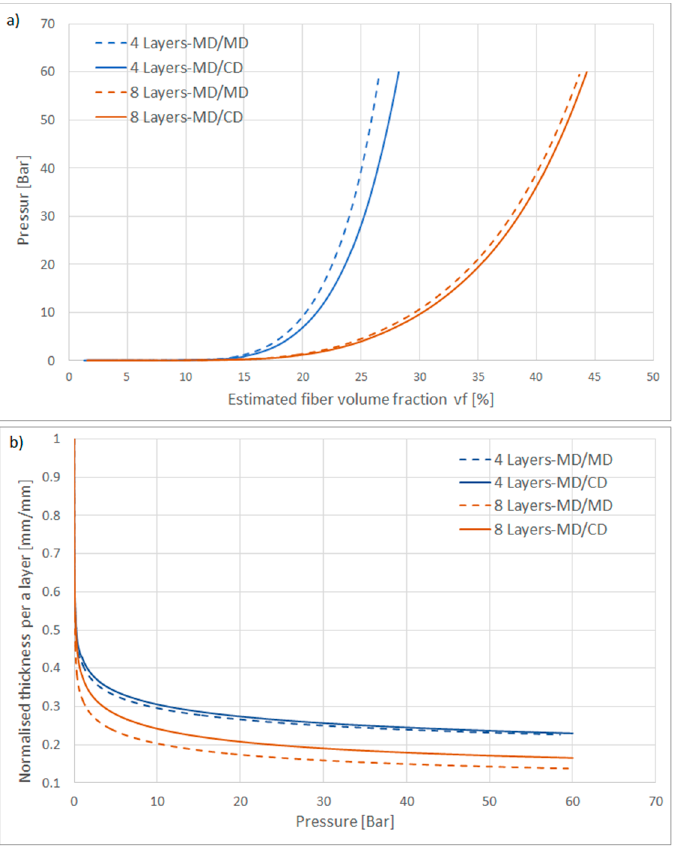
Figure 7. Pressure—estimated fibre volume fraction curve of 4 and 8 layers of nonwoven material tested in MD/MD and MD/CD laminate sequence ( a ) and normalised thickness of preform per layer of tested samples relative to its thickness per layer at 0.01 bar as a function of applied pressure ( b ).